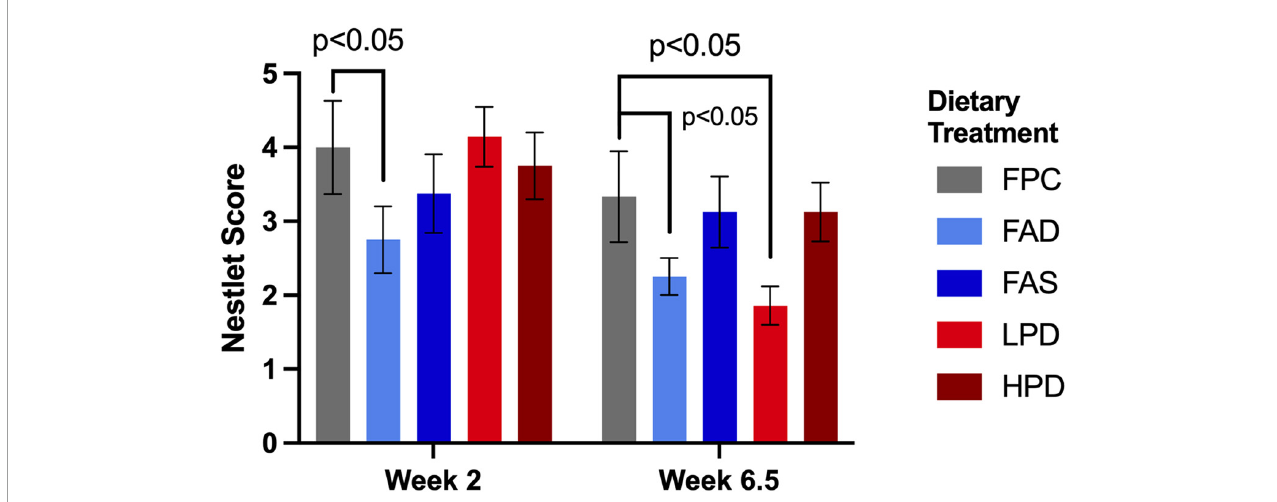
FIGURE3 Effect of dietary treatment upon nestlet building as measured by a Nestlet Score of 1 to 5 at weeks 2 and 6.5. C57BL/6J mice were provided these 5 experimental diets: (1) 0 mg/kg folic acid FA/17.9% protein, TD.150200, FA Deficient (D) Diet (FAD; n = 16); (2) 2 mg/kg FA/17.9% protein; TD.150201, Control (C) FA Protein (P) Diet (FPC; n = 12); (3) 7 mg/kg, FA/17.9% protein; TD.15202, FA Supplemented (S) Diet (FAS, n = 16); (4) 2 mg/kg FA, 6% protein [Low Protein Diet (LPD, n = 16)]; and (5) 2 mg/kg FA/48% protein [High Protein Diet (HPD, n = 16)]. The results are means ∼ + SEM ( n = 8). p < 0.05, week